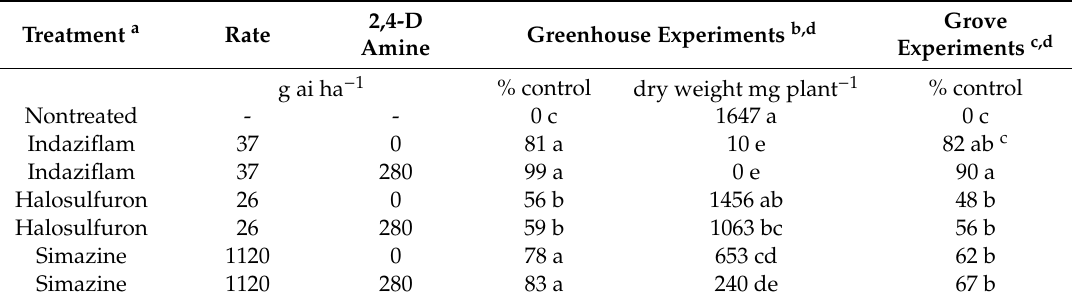
Table 1. E ff ect of herbicide treatment on Plantago lanceolata L. control in greenhouse experiments and from autumn applications in Carya illinoinensis (Wangenh.) K. Koch groves in Webster County